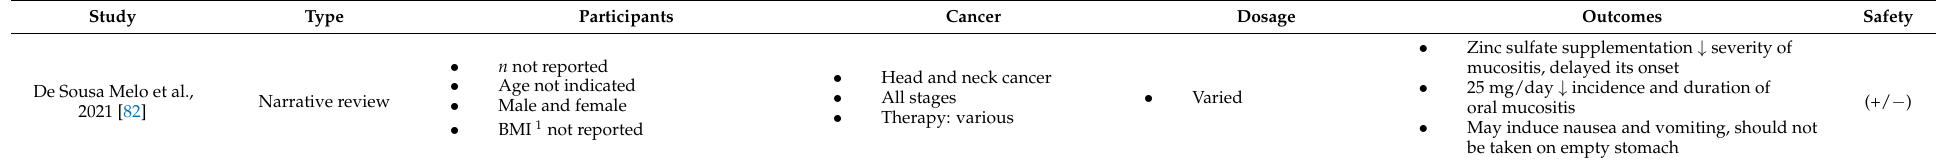
Table 5. Safety of zinc supplements for patients with